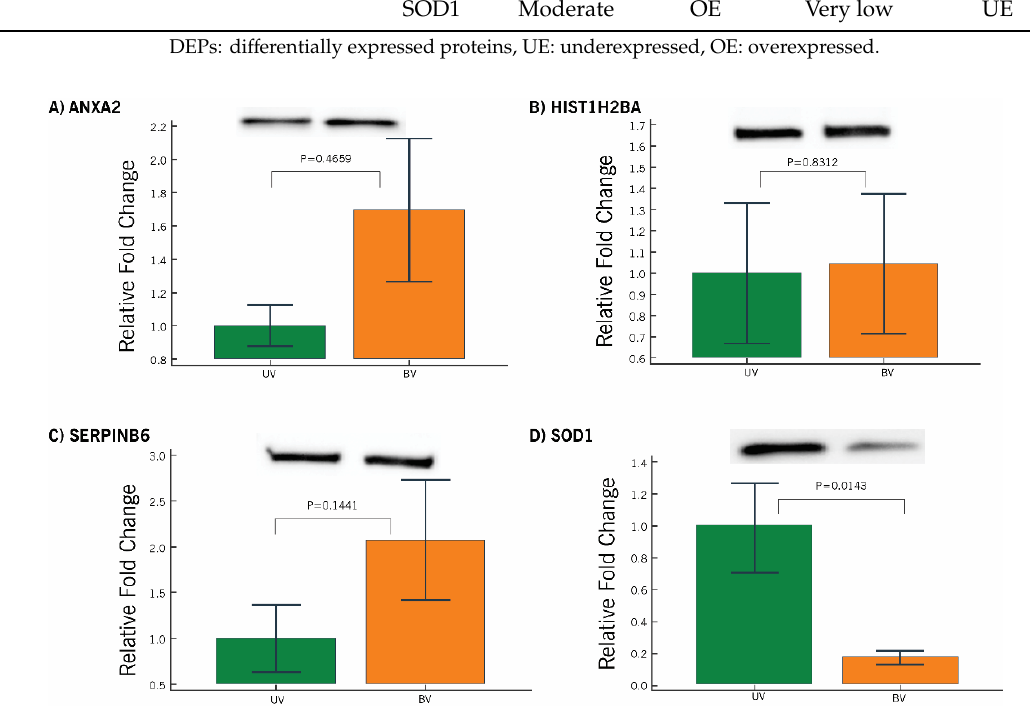
Figure 7. Western blot analysis of proteins associated with the acetylation process in unilateral and bilateral varicocele infertile men. ( A ) Annexin A2 (ANXA2), ( B ) histone H2B type 1-A (HIST1H2BA), ( C ) serpin B6 (SERPINB6), ( D ) superoxide dismutase 1 (SOD1). Results are expressed as mean ± standard error of mean and in fold variation to the unilateral varicocele group.